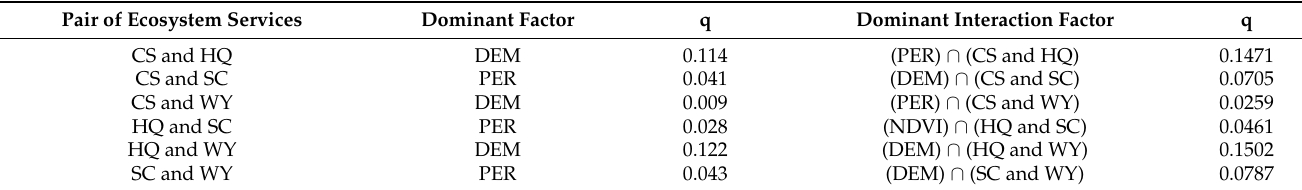
Table 4. Interaction detection between ecosystem services in the LP, 2015. Pair of Ecosystem